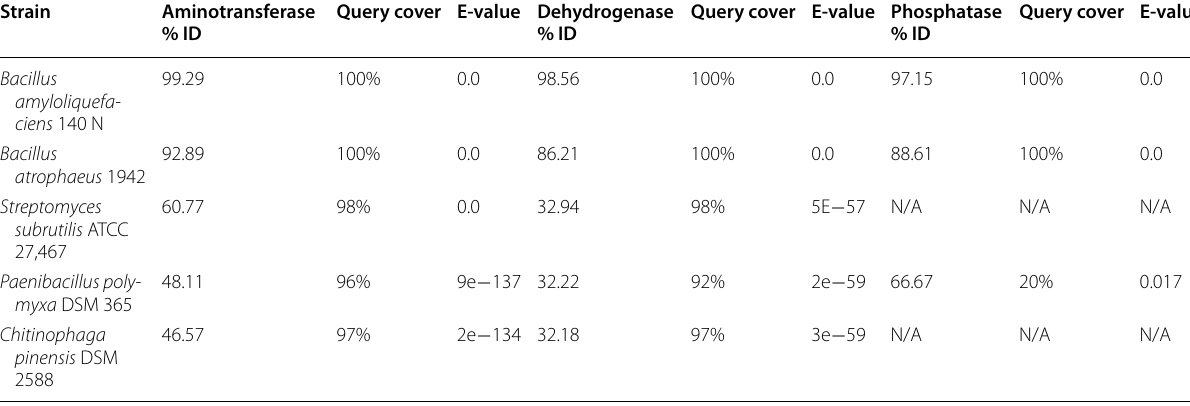
Table 1 pBLAST scores of the five known azasugar producers against Bacillus velezensis FZB42 with correlating E-values Strain Aminotransferase Query cover E-value Dehydrogenase Query cover E-value Phosphatase Query cover % ID % ID % ID